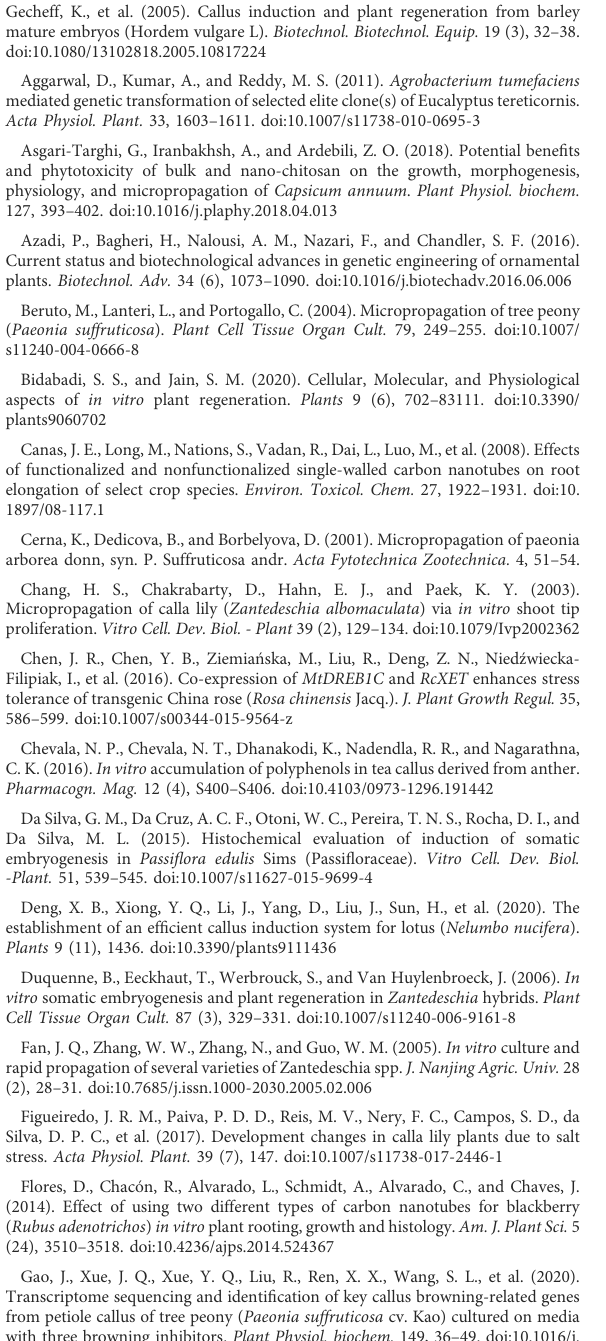
Figueiredo, J. R. M., Paiva, P. D. D., Reis, M. V., Nery, F. C., Campos, S. D., da Silva, D. P. C., et al. (2017). Development changes in calla lily plants due to